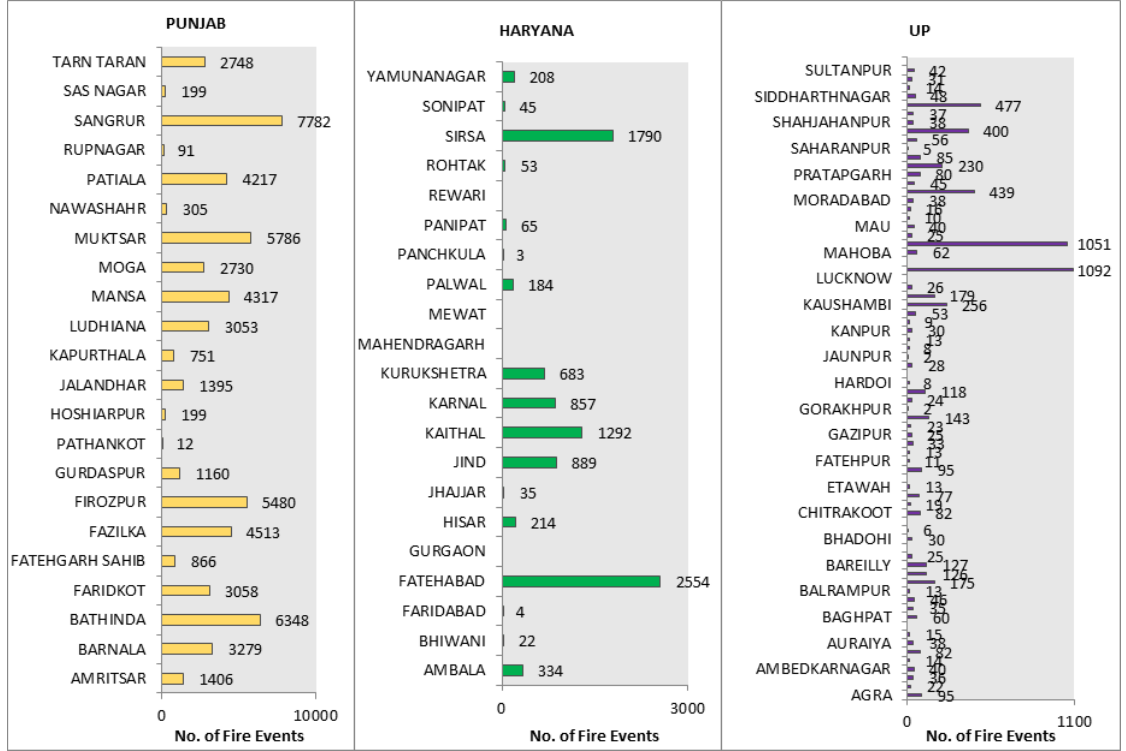
Figure 7. District-wise cumulative number of residue burning events over the period of 1 st October to 30 th November 2018. (Yellow: Punjab; Green: Haryana; Purple: Uttar